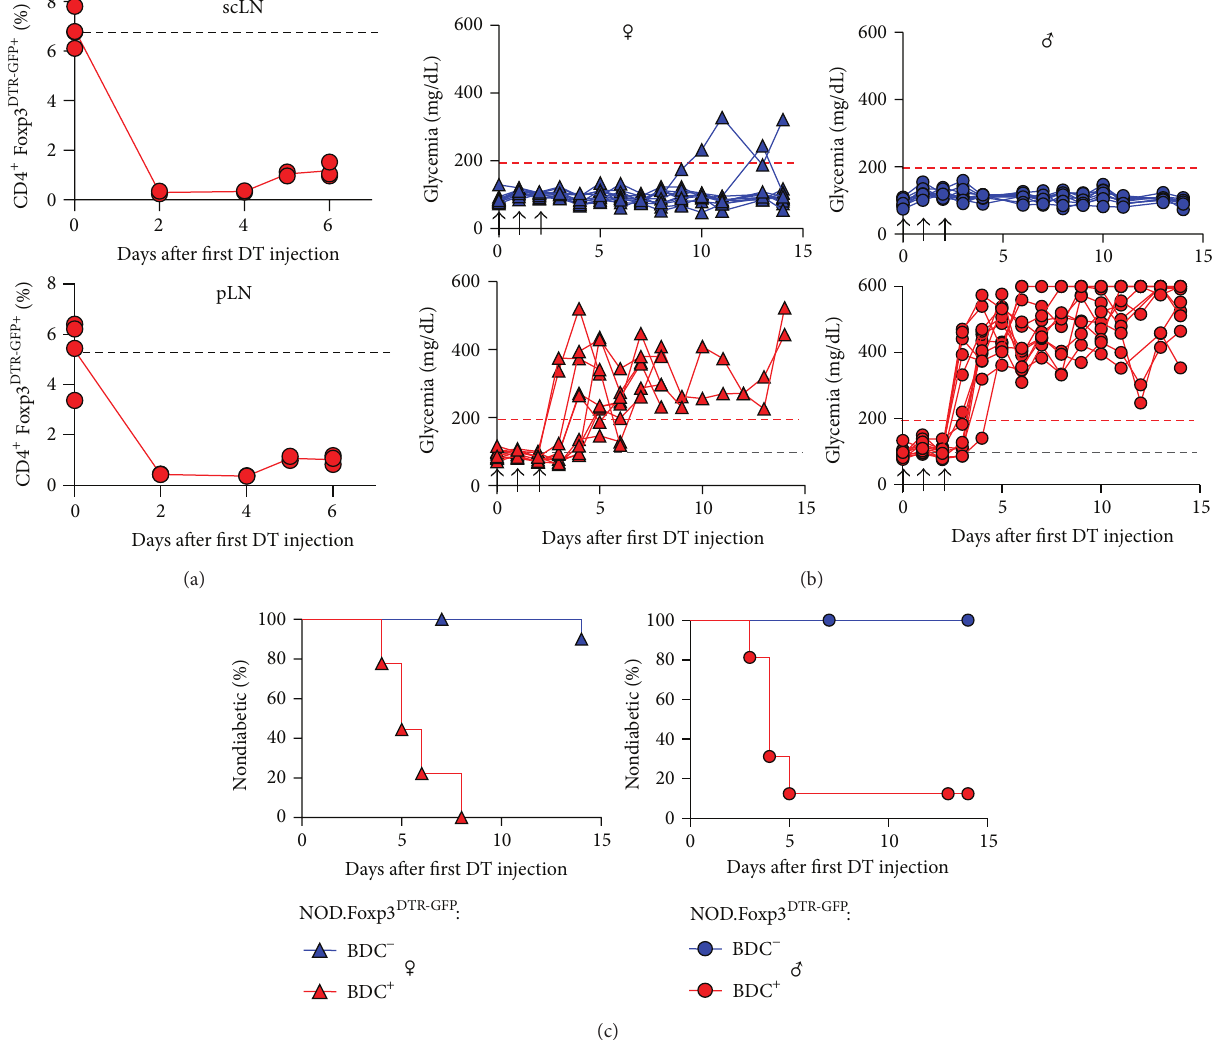
Figure 4: Foxp3 + Treg cell ablation in NOD.Foxp 3 DTR-GFP mice. (a) Percentage of Foxp 3 DTR-GFP + cells among CD4 + T cells in subcutaneous lymph nodes (scLN, top) and pancreatic LNs (pLN, bottom) of NOD.Foxp 3 DTR-GFP × BDC2.5 mice, which were either left untreated (dashed line) or i.p. injected with DT (0.5 𝜇 g/mouse on 3 consecutive days). Symbols represent individual mice at indicated time points after the first DT administration. (b) Blood glucose concentrations and (c) diabetes incidence of NOD.Foxp 3 DTR-GFP mice (blue triangles: females, 𝑛 = 11 ; blue circles: males, 𝑛 = 11 ) and NOD.Foxp 3 DTR-GFP × BDC2.5 mice (red triangles: females, 𝑛 = 9 ; red circles: males, 𝑛 = 12 ), after DT administration, as indicated by the